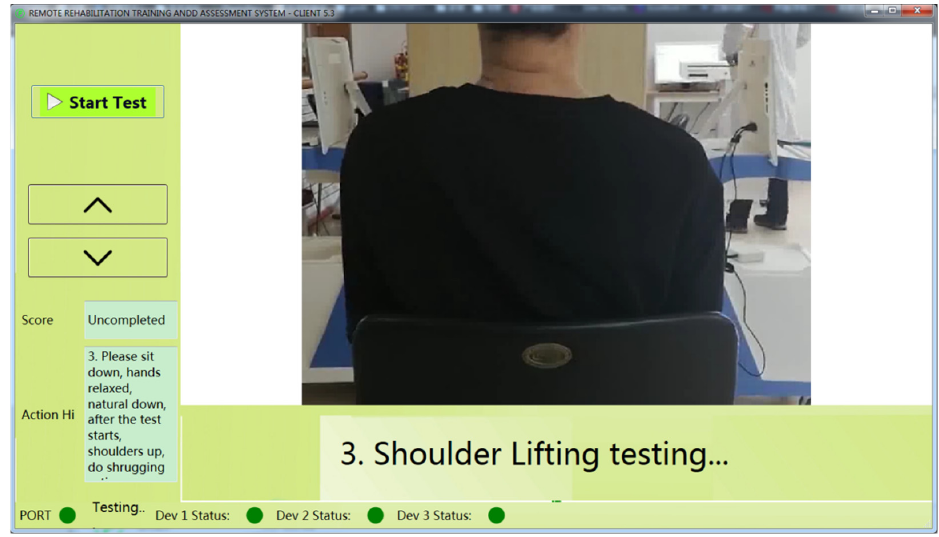
Figure 3. Rehabilitation assessment client